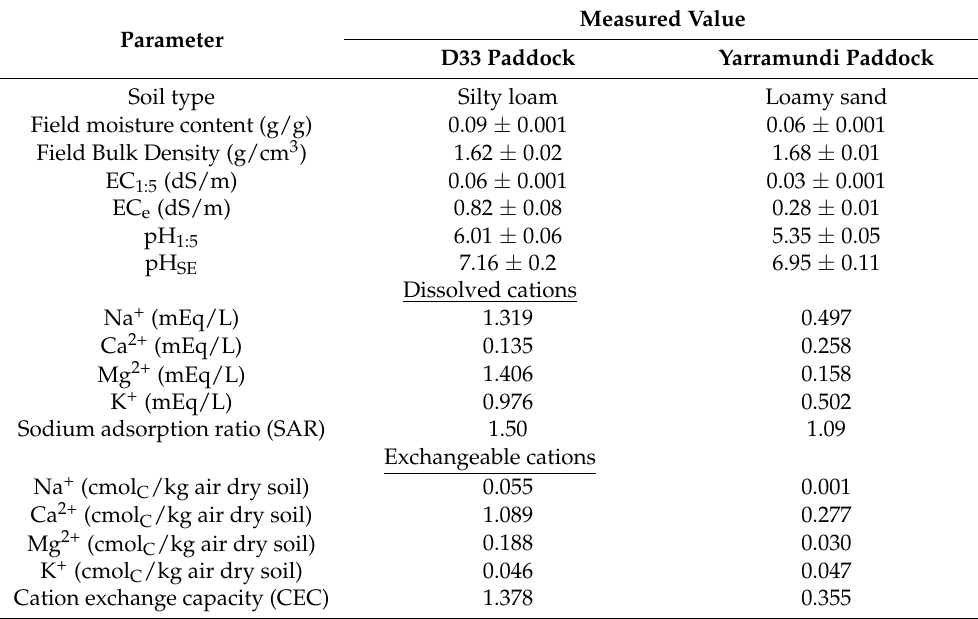
Table 2. Physico-chemical properties of soil collected from paddocks in the study